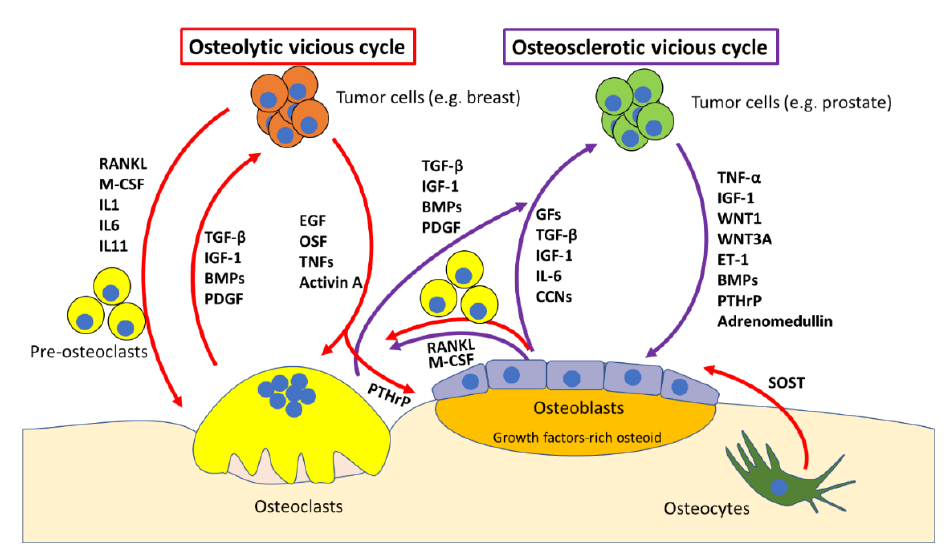
Figure 1. Cartoon representing the osteolytic and osteosclerotic vicious cycles. Osteolytic cycle: osteolysis-generating cancer cells (e.g., breast) migrate to the bone marrow and start secreting osteoclast-stimulating factors such as epithelial growth factor (EGF), osteoclast stimulating factor (OSF), tumour necrosis factors (TNFs) and Activin A. In parallel, cancer cells also secrete osteoclast-differentiating factors, such as receptor activator of nuclear factor kB ligand (RANKL), macrophage-colony stimulating factor (M-CSF) and Interleukin (IL)-1, 6 and 11, which promote differentiation of pre-osteoclasts into osteoclasts. The bone matrix is rich in growth factors (GFs), transforming growth factor (TGF)- β , insulin-like growth factor (IGF)-1, bone morphogenic proteins (BMPs) and platelet-derived growth factor (PDGF). These factors get released when osteoclasts resorb bone, and they promote tumour growth, which closes the osteolytic vicious cycle. Osteocytes also take a crucial part in the process, secreting sclerostin (SOST) in response to osteolytic cancers (especially multiple myeloma), which inhibits osteoblast activity and the Wnt- β -catenin pathway Osteosclerotic cycle: osteosclerosis-generating cancer cells (e.g., prostate) migrate to the bone marrow and start secreting osteoblast-stimulating factors such as TNF- α , IGF-1, Wingless-type MMTV integration site (WNT)1, WNT3A, Endothelin (ET)-1, BMPs, parathyroid hormone-related peptide (PTHrP) and adrenomedullin. This stimulates osteoblast differentiation and activity. On one hand this leads to osteoblast-mediated osteoclastogenesis by increasing osteoblastic expression of RANKL and M-CSF, which causes the release of growth factors as discussed for the osteolytic cycle. On the other hand, osteoblasts themselves release a plethora of factors including GFs, TGF- β , IGF-1, IL-6 and chemokines (CCNs), which stimulate tumour growth, closing the osteosclerotic (which most of the times has an osteolytic component as well) vicious cycle. In addition to PTHrP, numerous molecular players in the establishment of the osteoblastic vicious cycle have been identified. Prostate cancer cells secrete osteoblast-stimulating factors, including adrenomedullin, platelet-derived growth factor (PDGF), insulin-like growth factors (IGFs)